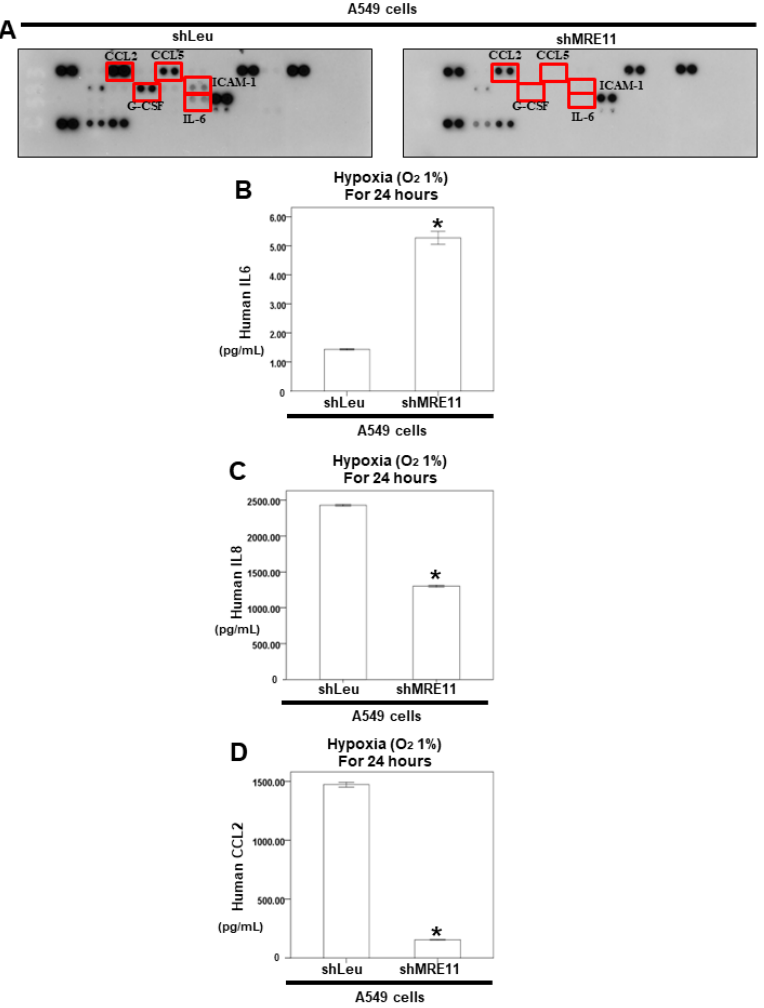
Figure 3. The protein secretion from A549 shLeu and A549 shMRE11 cells. ( A ) For cytokine array, the cultured medium of A549 shLeu and A549 shMRE11 cells were collected and analyzed by cytokine microarray. Array images were captured following a 5-min exposure to X-ray film. ( B – D ) For ELISA, the medium was collected from A549 shLeu and A549 shMRE11 cells after treatment with hypoxia for 24 h. The secretion of human IL-6, IL-8, or CCL2 was measured by ELISA kits. (Error bars = mean ± S.E.M. Asterisks (*) mark samples significantly different from the DMSO group with p <